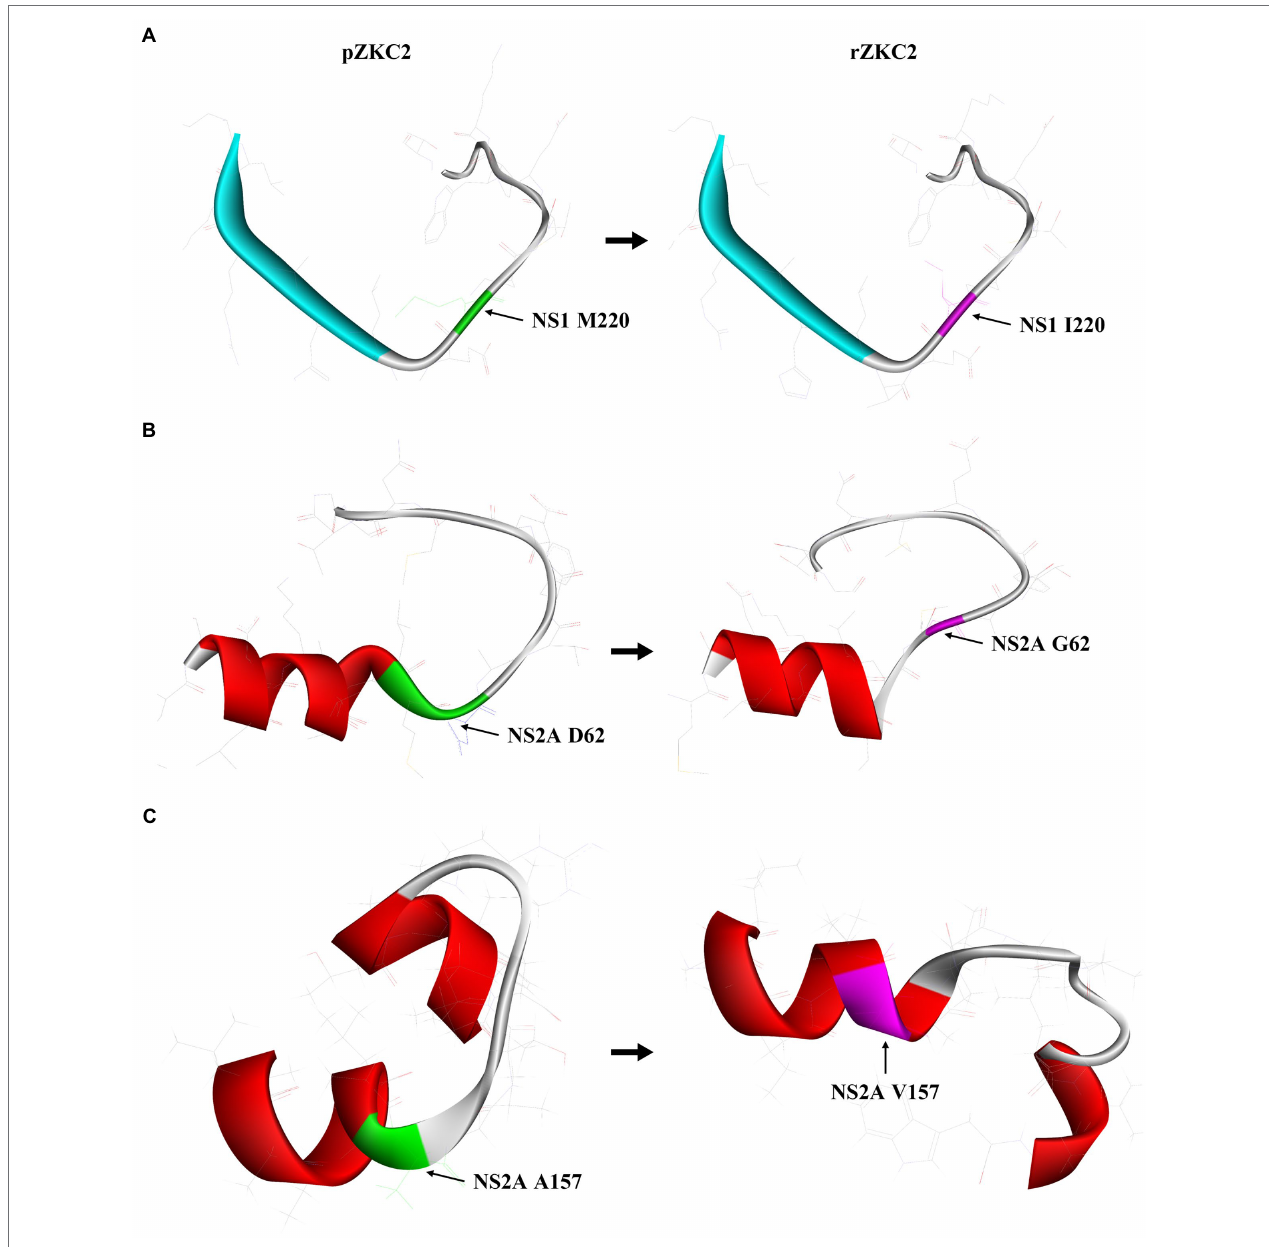
FIGURE 3 | The impact of three mutation on its protein structure. (A) 3D structure analysis of mutation M220I of NS1 protein residue 211–230. (B) 3D structure analysis of mutation D62G of NS2A protein residue 55–74. (C) 3D structure analysis of mutation A157V of NS2A protein residue